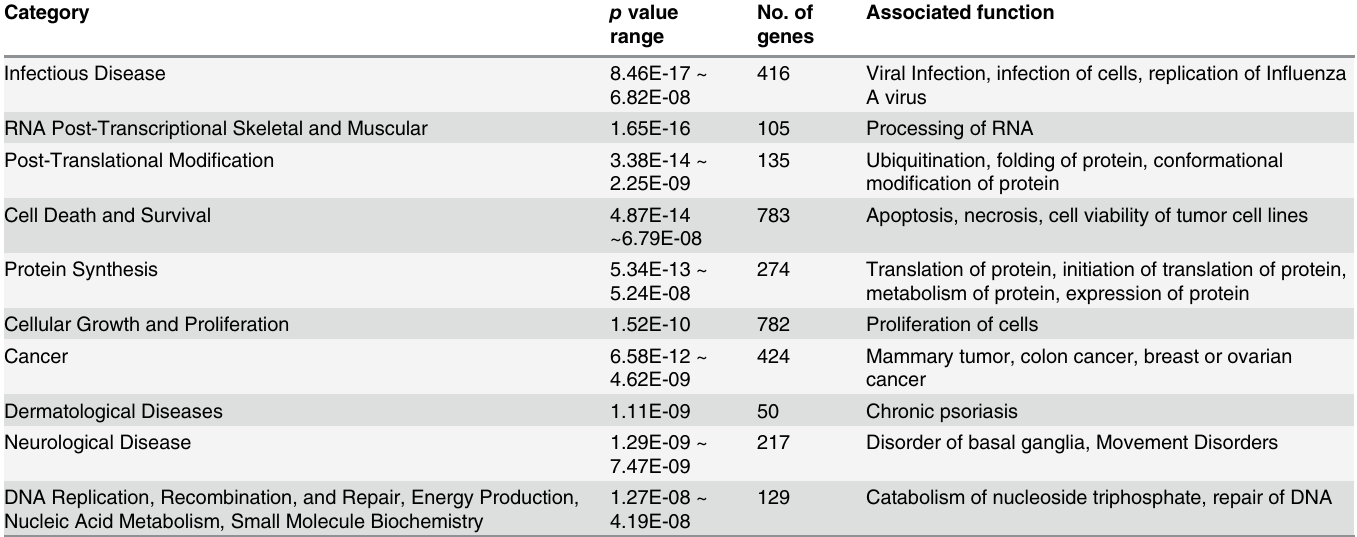
No. of Associated function range genes